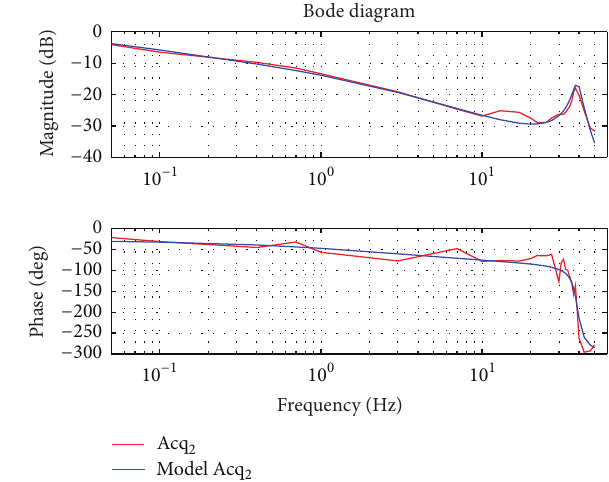
Figure 9: Magnitude and phase of the model on Acq 2 data via simplex method.